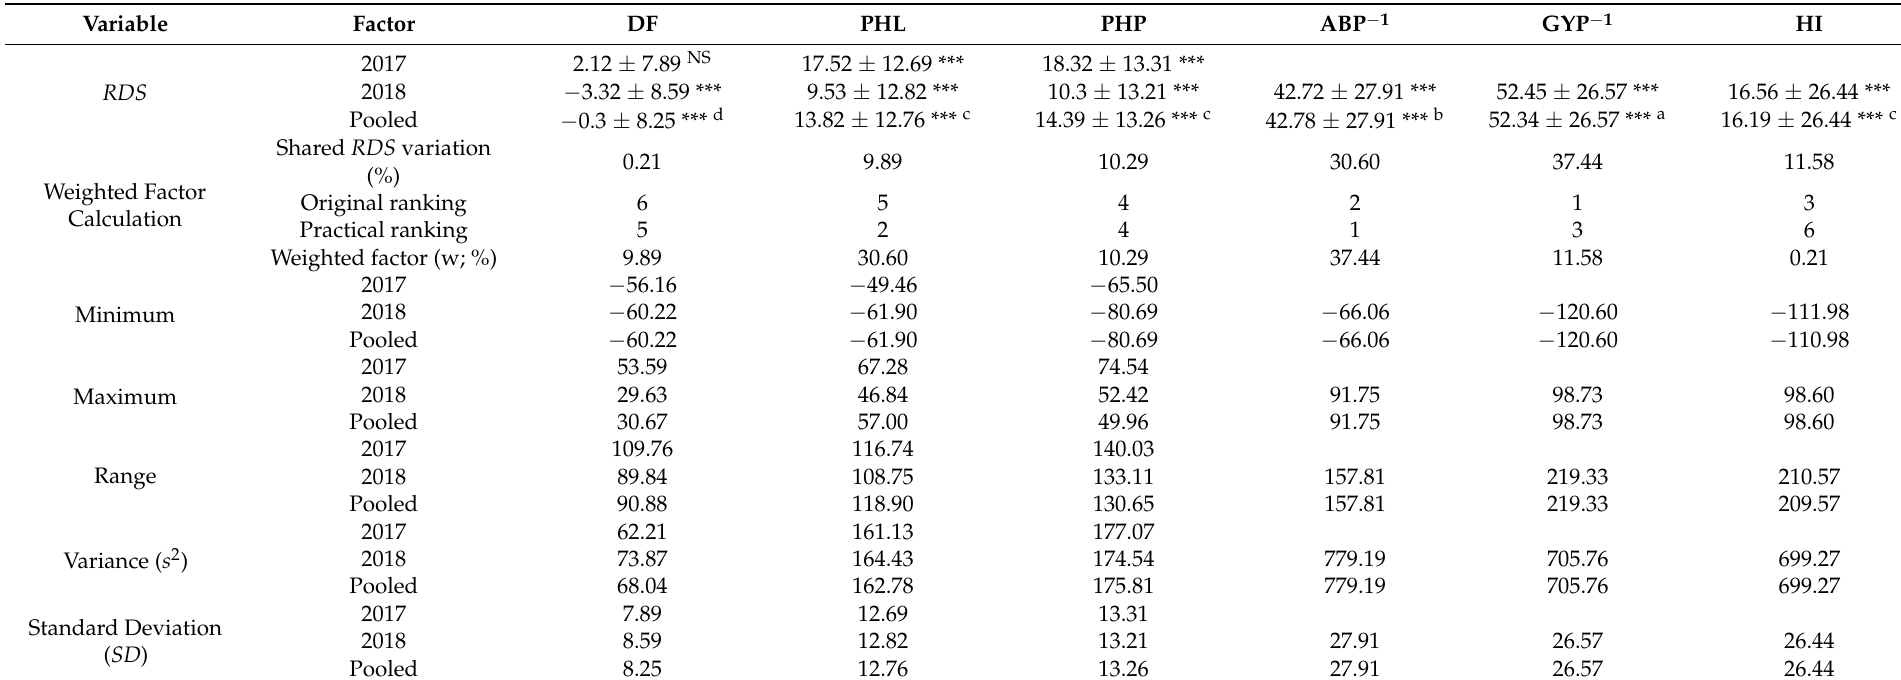
Table 6. Statistical analysis of RDS , derivation of weighted factor (w), range and variation of RDS for six traits in 2017, 2018 as well as pooled